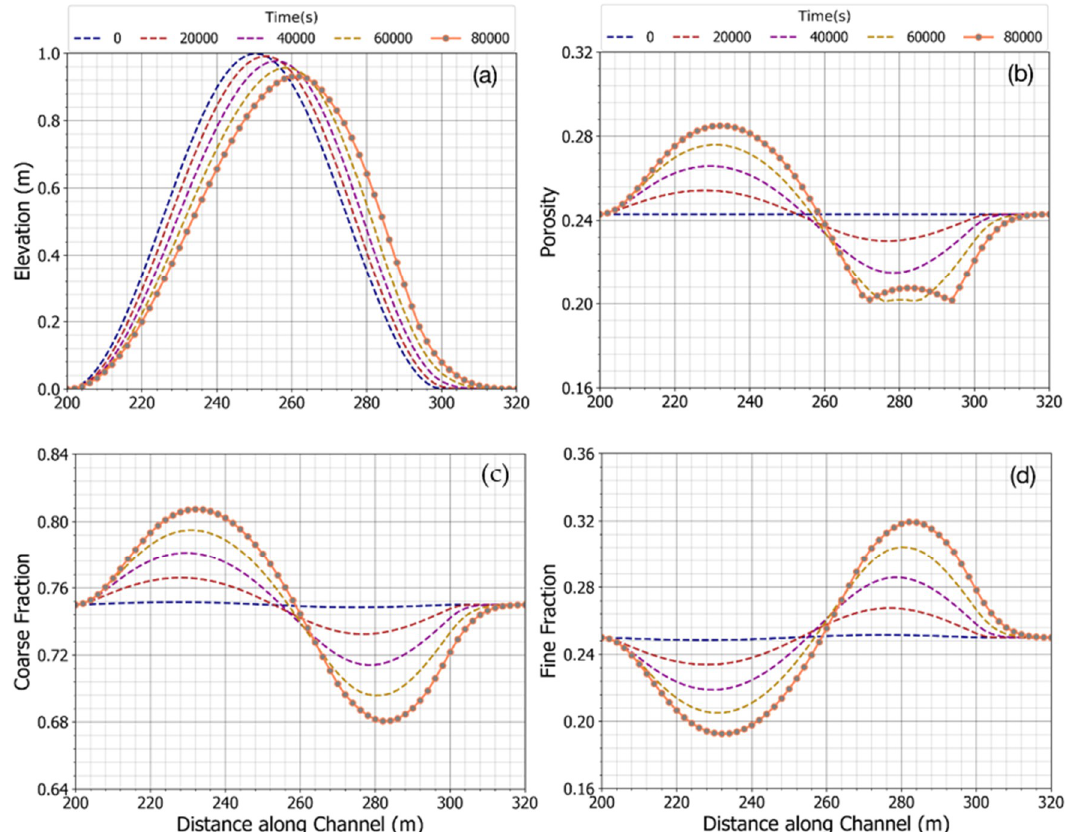
Figure 8. The performance of bed-porosity variation model in different times ( a )—Bed elevation; ( b )—Porosity of active-layer; ( c )—Coarse size fraction of active-layer; and, ( d )—Fine size fraction of active-layer.